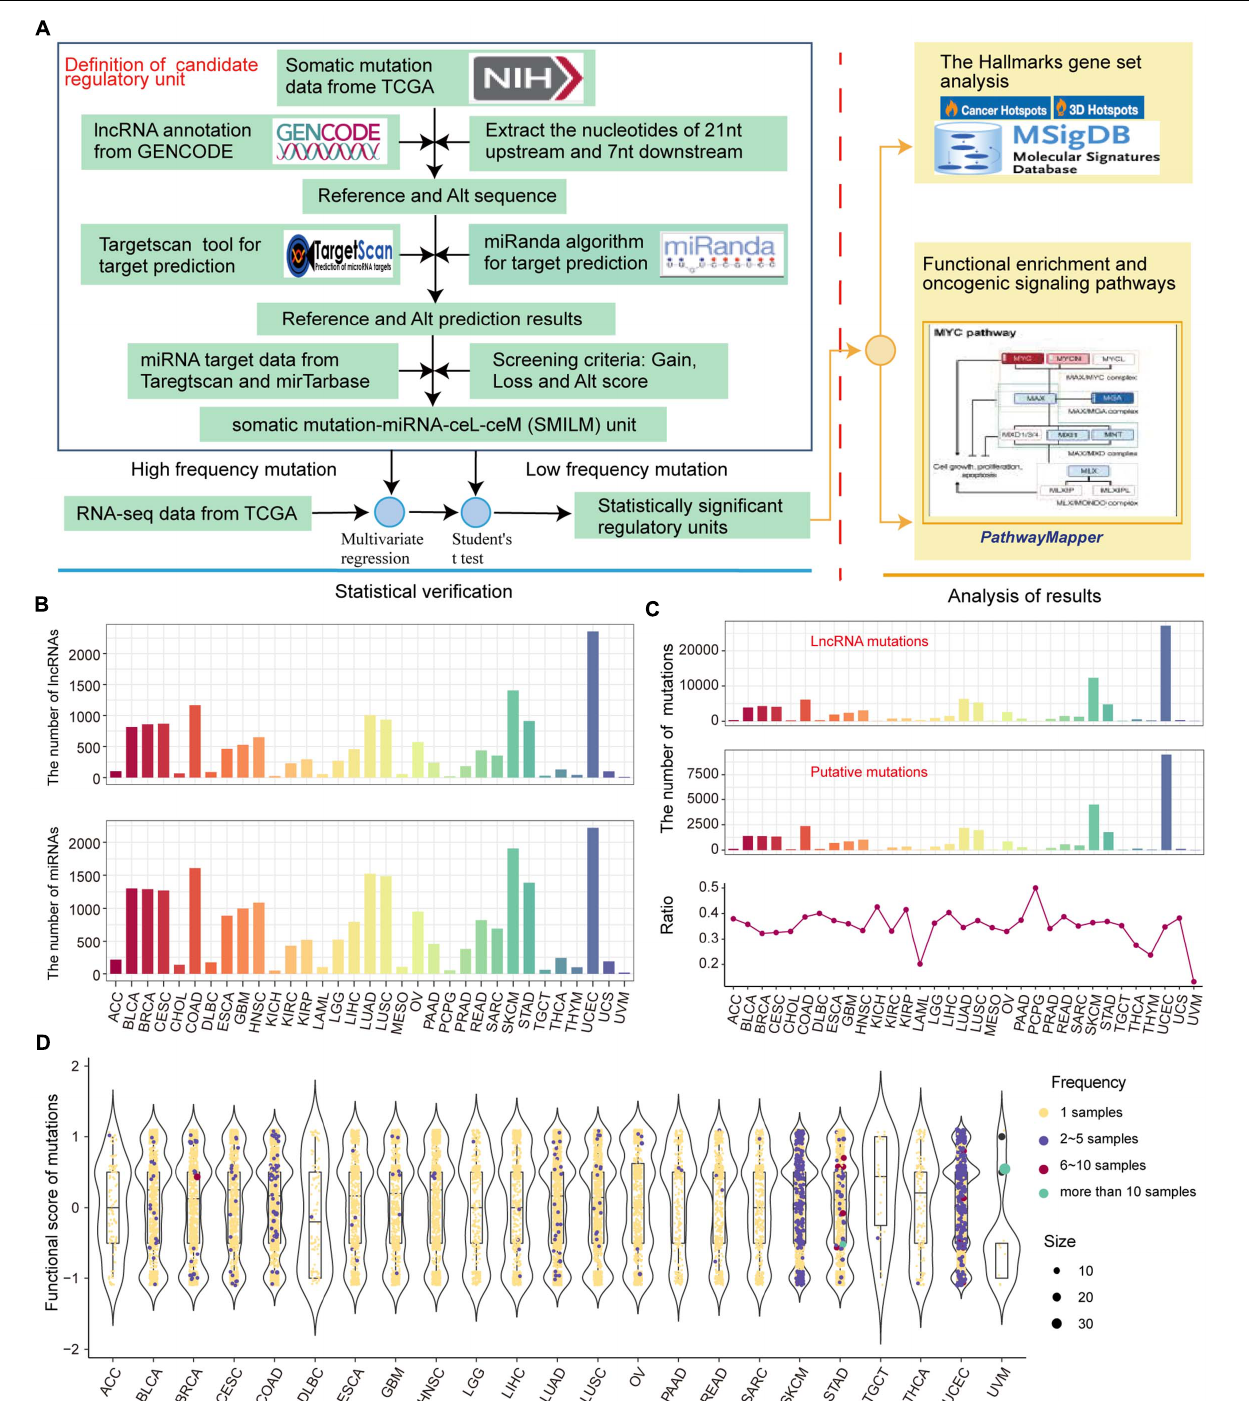
FIGURE 2 | Predicting somatic mutations on lncRNAs that potentially impact the ceRNA mechanism. (A) Workflow for SMILM unit construction, unit verification, and functional pathway analysis. (B) Numbers of lncRNAs and miRNAs affected by somatic mutations in different cancers. (C) Numbers of putative somatic mutations in SMILM units across 33 cancers is shown in a line chart. Proportions of putative mutations in each cancer type as a percentage of the original somatic mutations on lncRNA are shown by bar plot. (D) Functional scores of putative mutations in each cancer. Blue, red, green, and purple denote numbers of samples in which a particular mutation